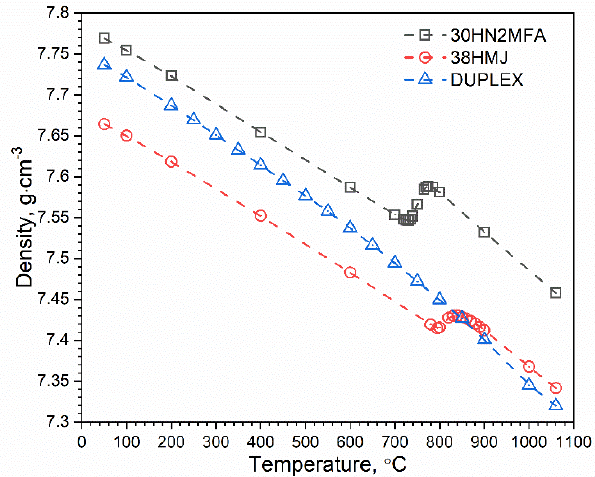
Figure 5. Density of chosen barrel steels: 30HN2MFA, 38HMJ, DUPLEX [12]. Table 4. Data on density of selected barrel steels [12].